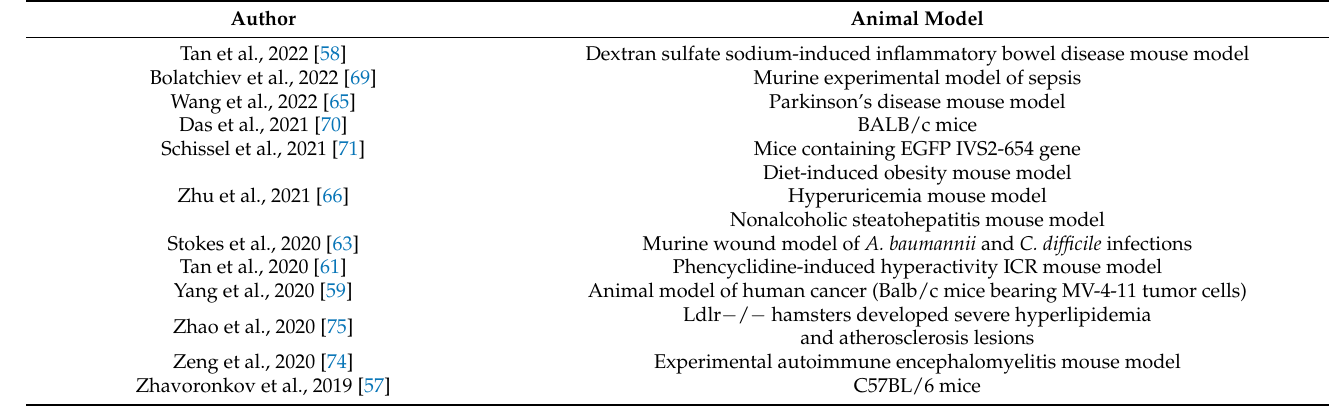
Table 4. A selection of the animal models used in each study for biological evaluation.